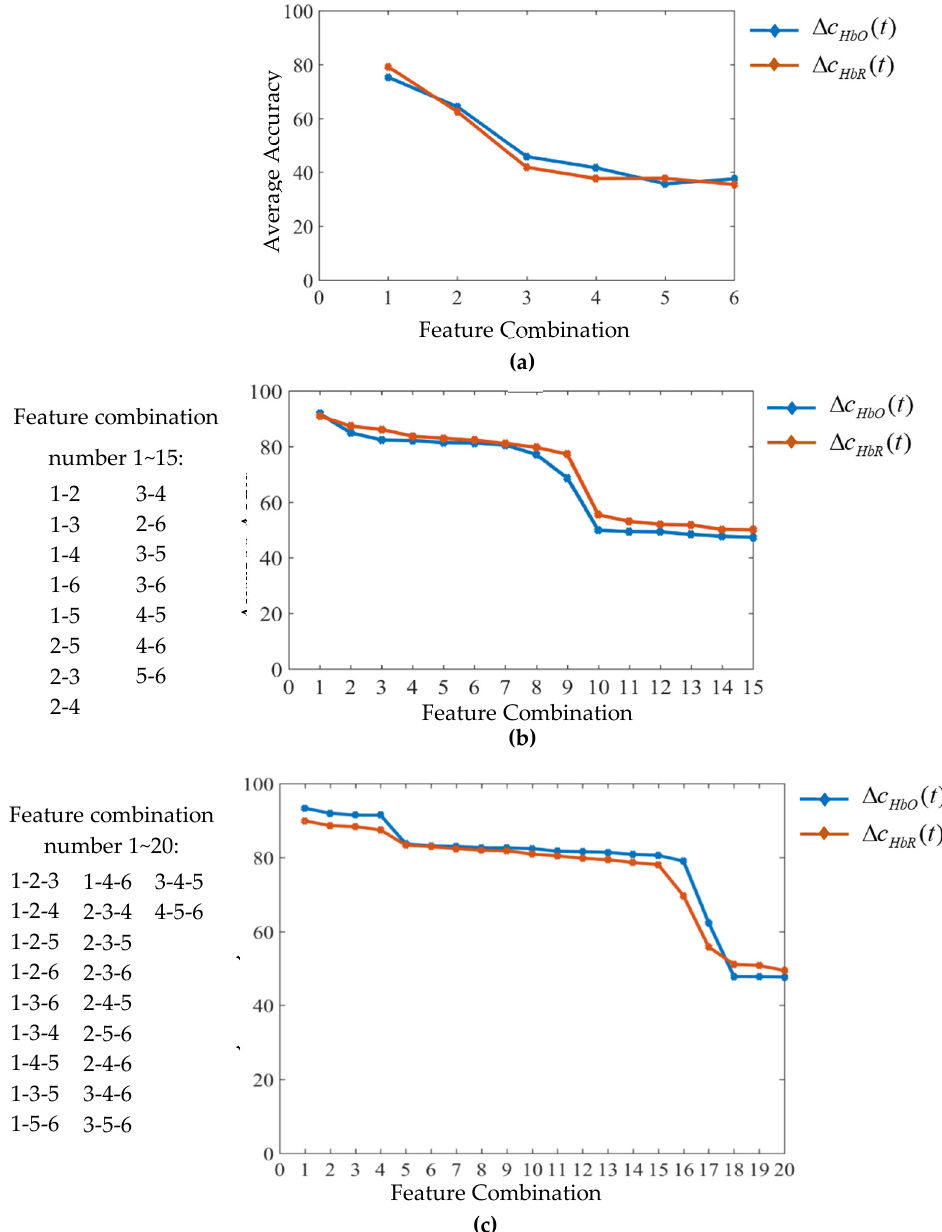
Figure 7. The comparison among classification accuracies. ( a ) All 1-feature averaged across all subjects using ∆ c HbO ( t ) and ∆ c HbR ( t ) signals; ( b ) all 2-feature possible combinations averaged across all subjects using ∆ c HbO ( t ) and ∆ c HbR ( t ) signals; and ( c ) all 3-feature possible combinations averaged across all subjects using ∆ c HbO ( t ) and ∆ c HbR ( t ) signals.